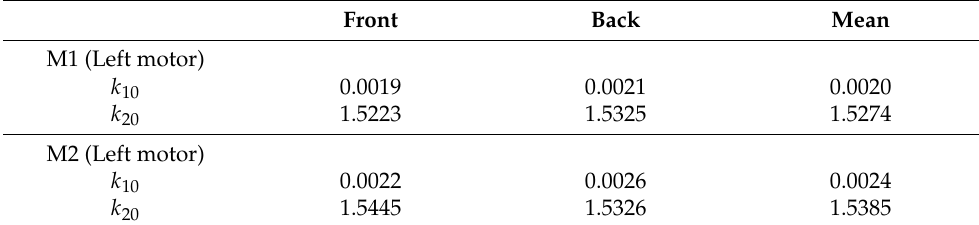
Table 1. Friction constants as measured through different wheels.